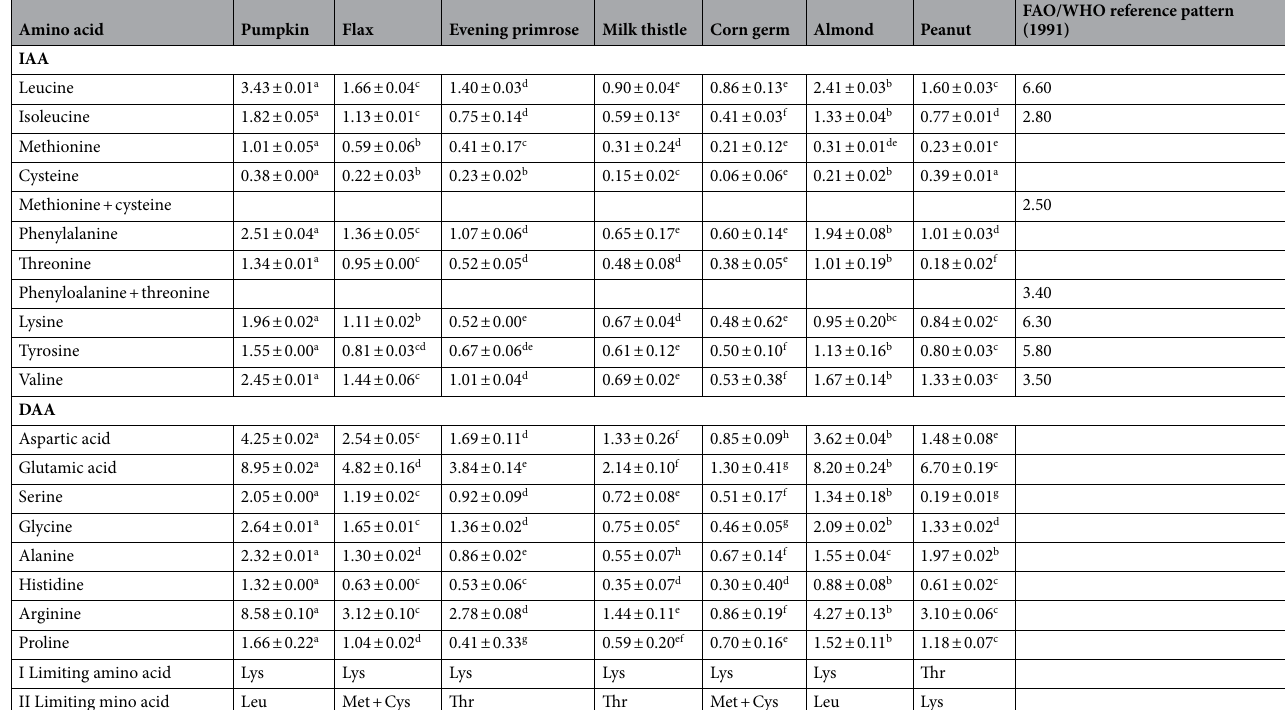
Table 3. Amino acid concentration (g/100 g) of flours from oilseed cakes. Values are means ± SD of three determinations. a,b,c,d,e,f,g The same letters within the same row were not significantly different. IAA indispensable amino acids, DAA dispensable amino acids.